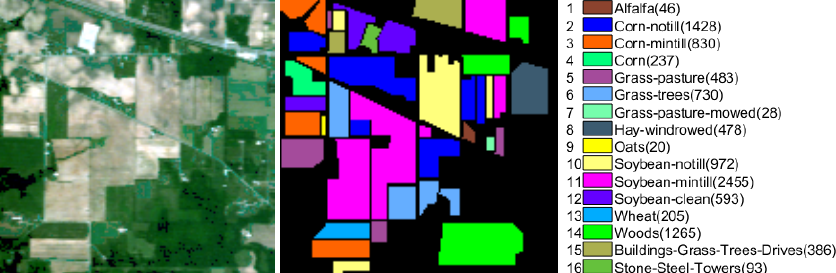
Figure 2. The false color composition and ground truth of Indian Pines data with numbers of samples for each class in brackets.